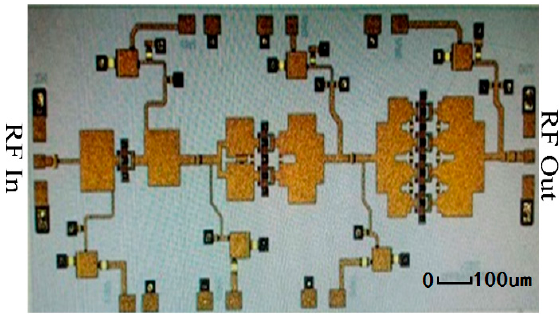
Figure 14. Photograph of a W-band Gallium Nitride (GaN) monolithic microwave integrated circuits (MMIC)